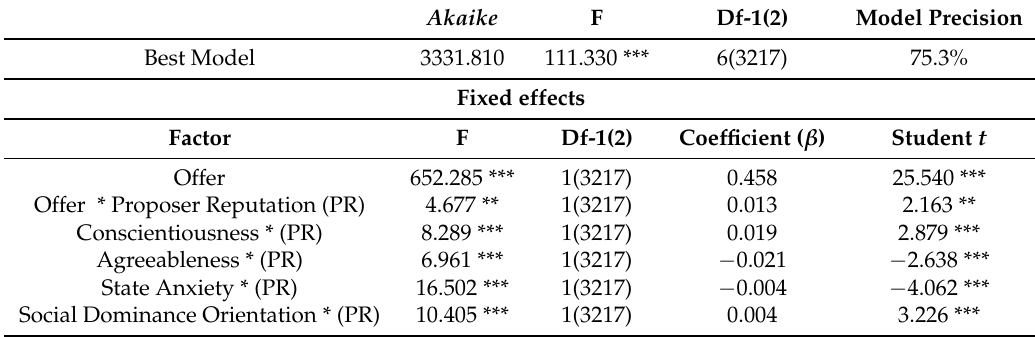
Table 6. Generalised Linear Mixed Models 3. Effects of Reputation and “Reputation Susceptibility” on the Rating